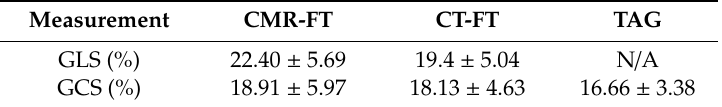
Figure 4. Assessment of GCS in the same subject from the mid-ventricular short-axis (SAX) view using CMR-FT ( left ), CT-FT ( middle ), and TAG ( right ). Table 3. Values of strain assessment of the LV by CMR and